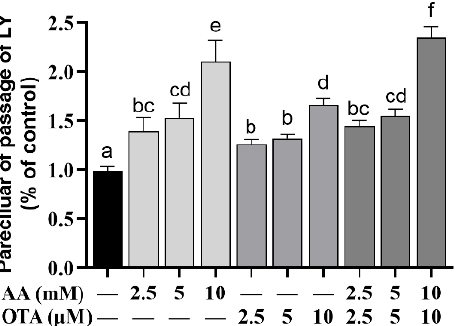
Figure 4. Effect of AA and OTA on the permeability of LY. a–f Different letters indicate significant differences, p < 0.05.